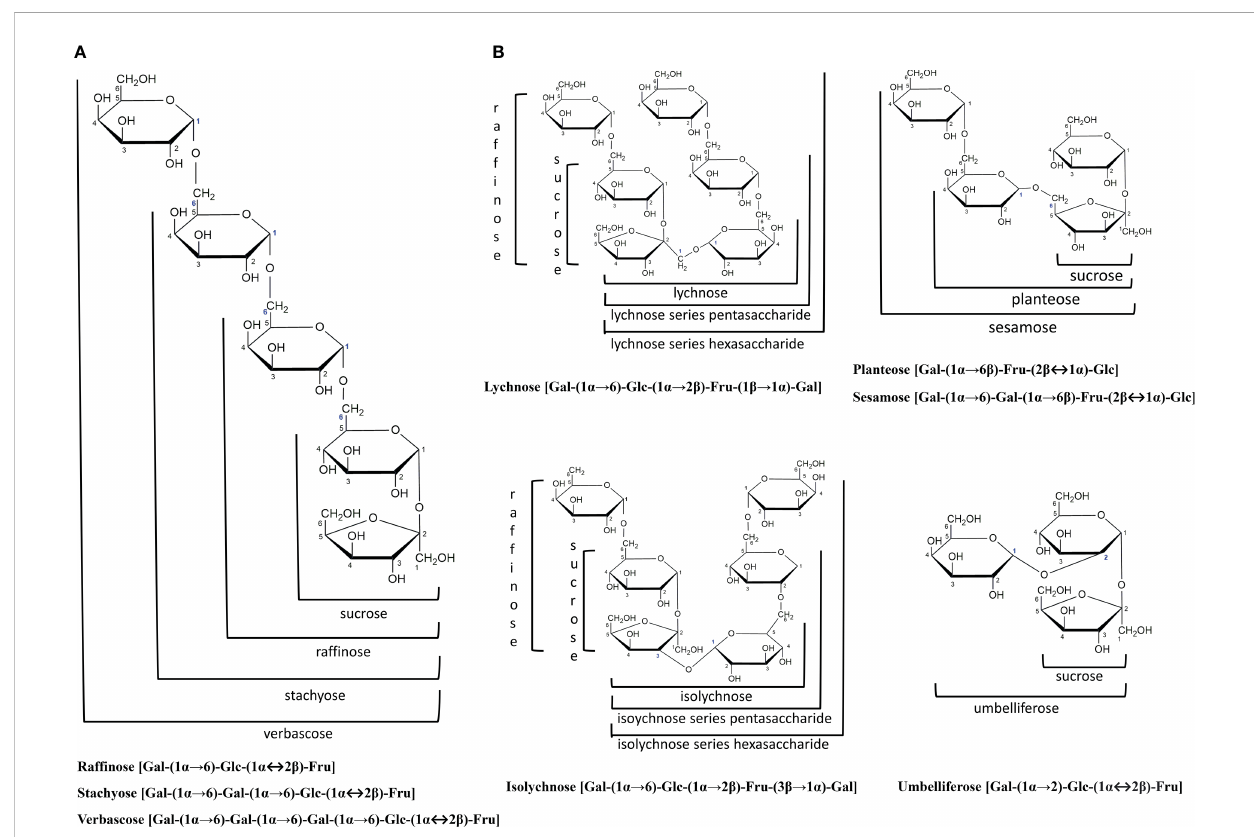
FIGURE 1 The general structure of raf fi nose family oligosaccharides (RFOs) and their related families. (A) RFOs are a (1-6) galactosyl substituted derivatives of the sucrose molecule, forming a non-reducing oligosaccharide. Raf fi nose, Stachyose and Verbascose are the major RFOs members in plants. (B) RFOs isomers with galactosidic linkages at other carbons of glucose (Umbelliferose), fructose (Planteose and Sesamose), or raf fi nose (Lychnose and Isolychnose). These classes do not fall under the RFOs. Structures were drawn with ChemDraw (version 12.0.2)